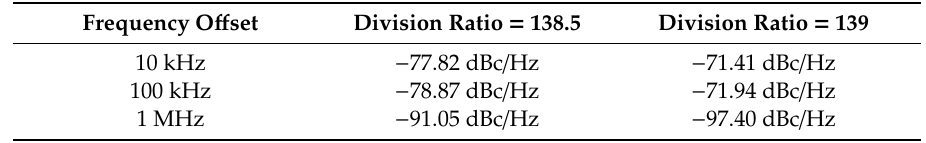
Figure 13. ( a ) Phase noise of PLL as the division ratio = 138.5; ( b ) Phase noise of PLL as the division ratio = 139. Table 2. Phase noise of PLL different division ratios.